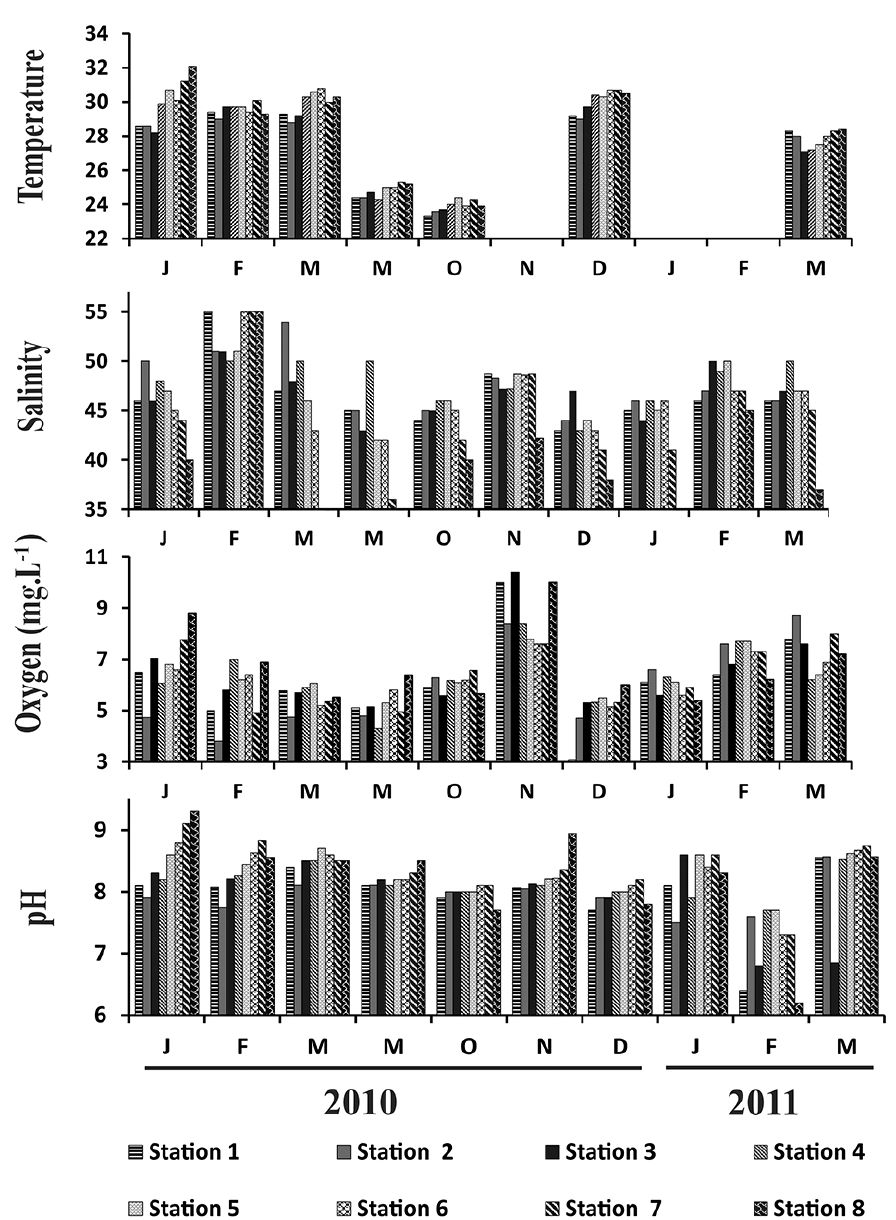
Figure 2. Variation of multiple factors (temperature, salinity, oxygen ( mg.L -1 ), and pH) in each collection station over the sampled months of 2010 and